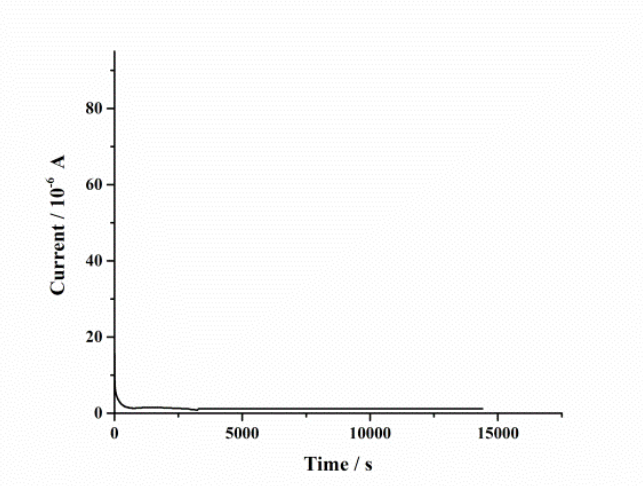
Figure 3: DC polarization graph of the GPE with stainless steel electrodes at room